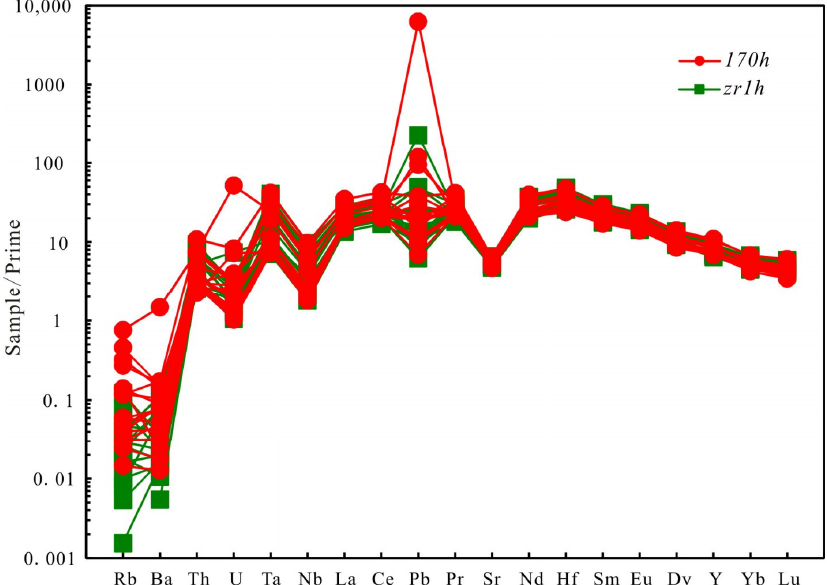
Figure 6. Multiple trace element patterns, normalized to the primitive mantle for the clinopyroxenes from Well CK-2.